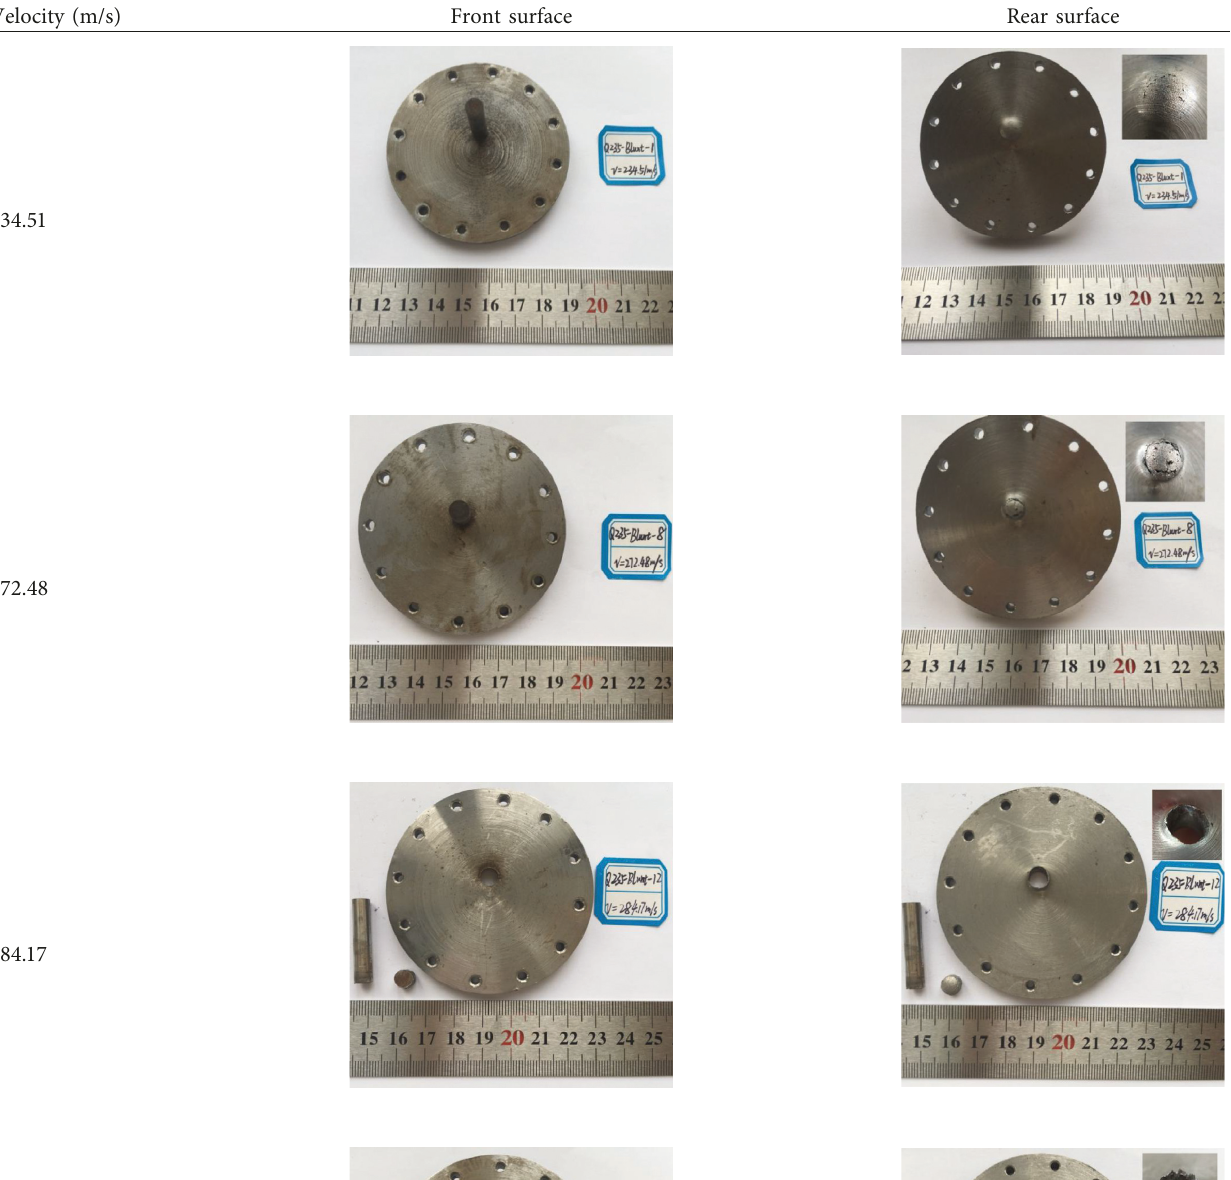
Table 4: Failure mode of steel target plate under projectile impact at different